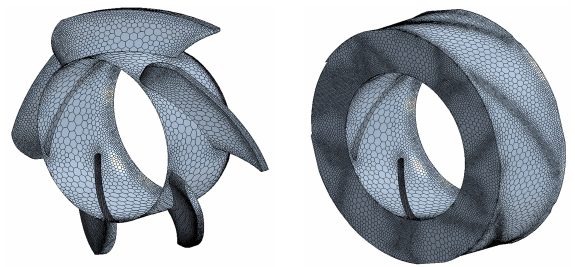
Figure 9. Mesh grid of the fan blades (left) and the total rotating region